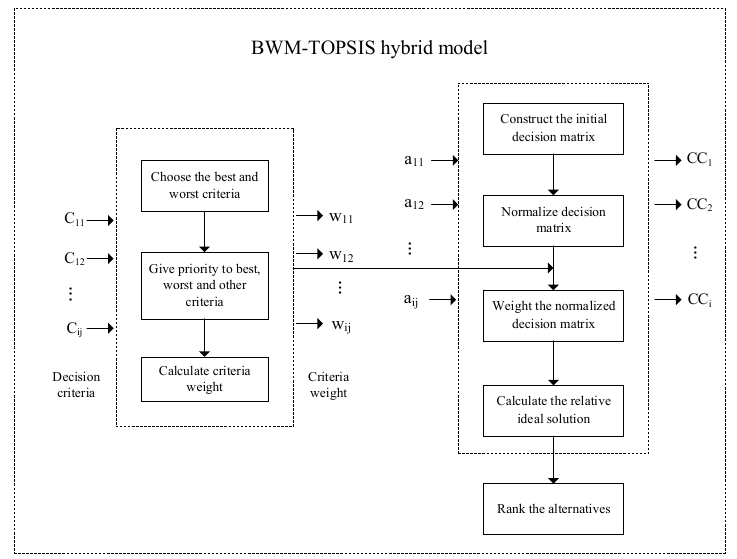
Figure 1. Hazardous waste inventory risk evaluation methodological framework.